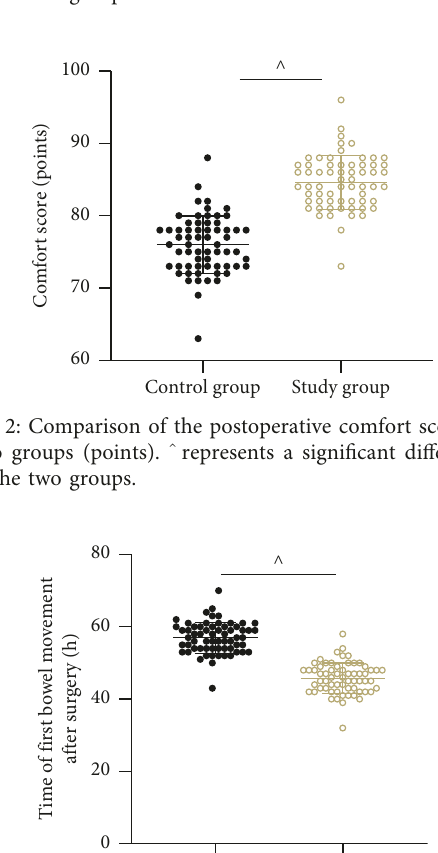
Figure 1: Comparison of the postoperative anal pain level within the two groups (persons). ^ represents a significant difference be- tween the two groups.